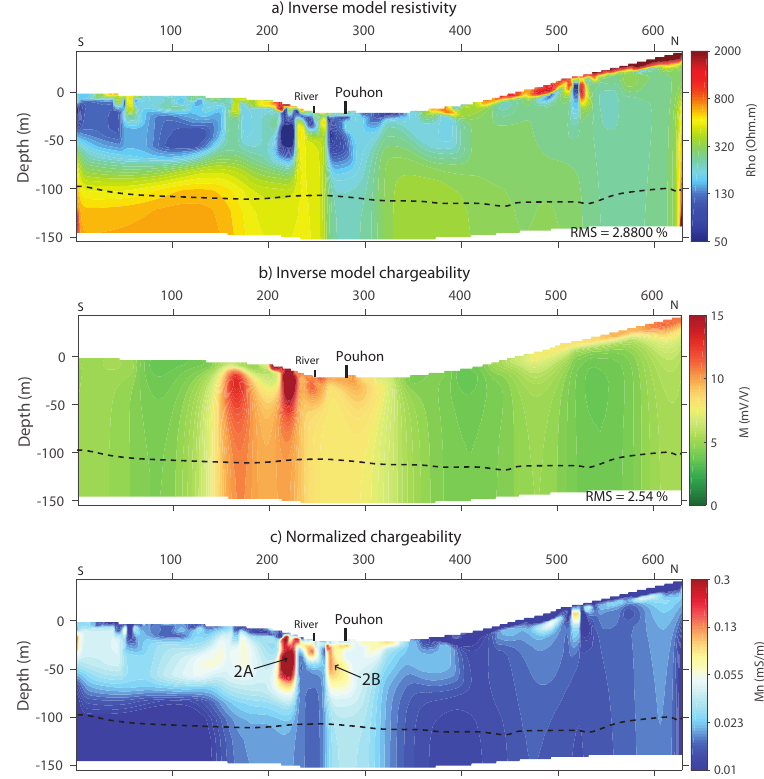
Figure 9. Resistivity, chargeability and normalized chargeability distributions in Profile 2. The location of the pouhon is indicated. Horizontal positions are given in m . The dashed black line indicates the limit below which the DOI value exceeds the trust threshold value of 0.2. The two main normalized chargeability anomalies are numbered 2A and